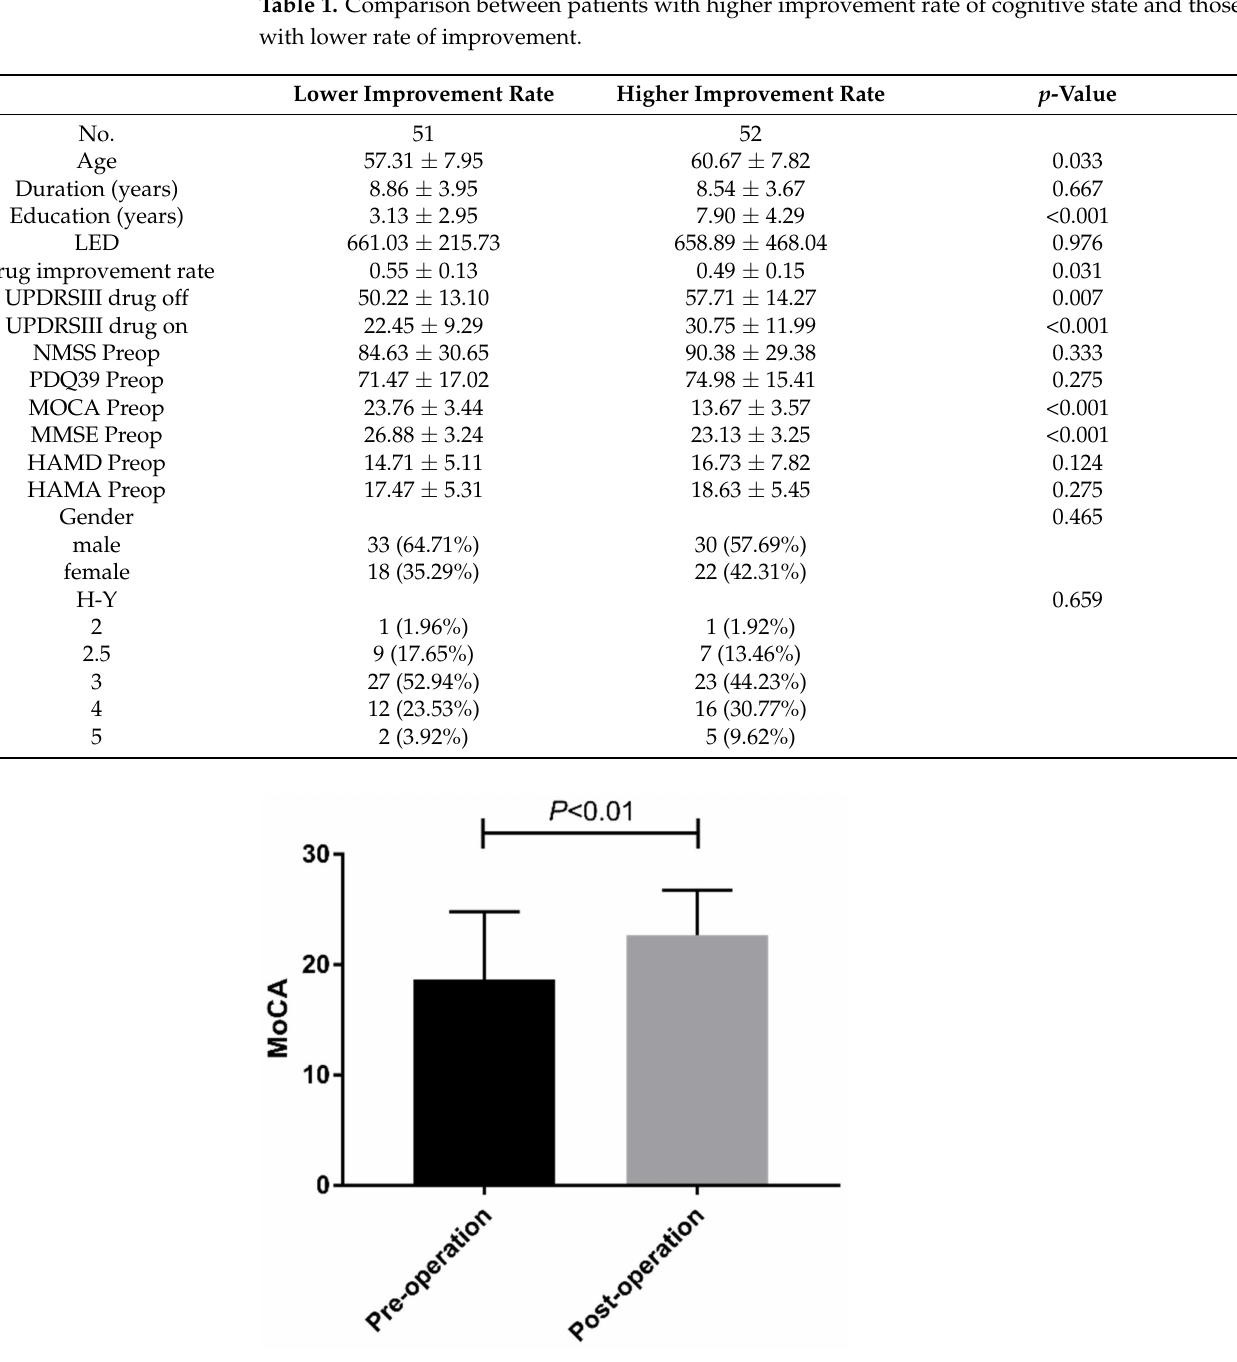
Figure 1. Comparison of MoCA score between pre-operation and one year after